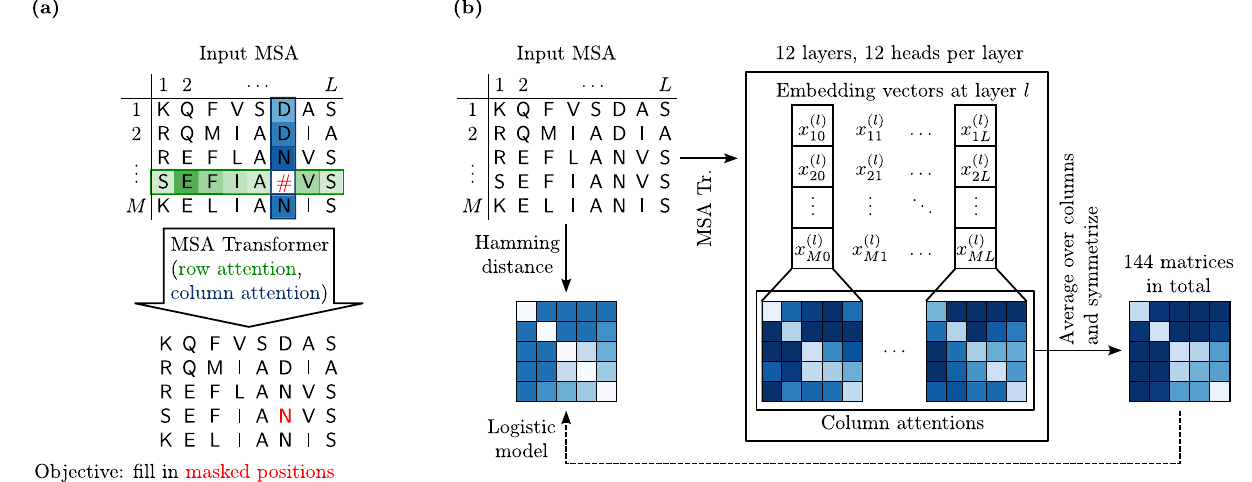
b Our approach for Hamming distance matrix prediction from the column atten- tions computed by the trained MSA Transformer model, using a natural MSA as input.Foreach i =1, … , M , j =0, … , L and l =1, … ,12,theembeddingvector x ð l Þ ij isthe i -th row of the matrix X ð l Þ fi ned in “ Methods – MSA Transformer and column j de attention ” , and the column attentions are computed according to Eqs. (2) and